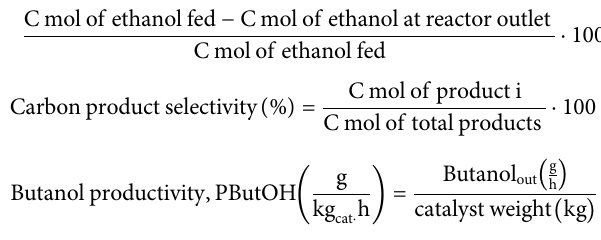
Frontiers in Chemistry |